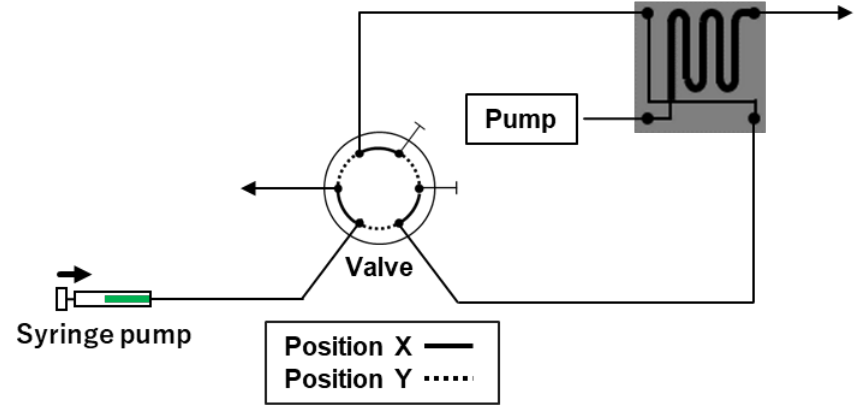
Figure 1 . Schematic of the improved automated sample injection system . Figure 1. Schematic of the improved automated sample injection